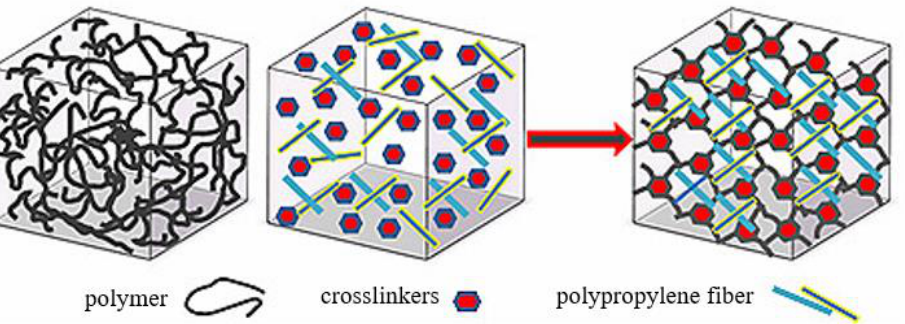
Figure 3. Schematic Diagram of the Skeleton Structure of polypropylene fiber strengthened Naph- thol Gel.